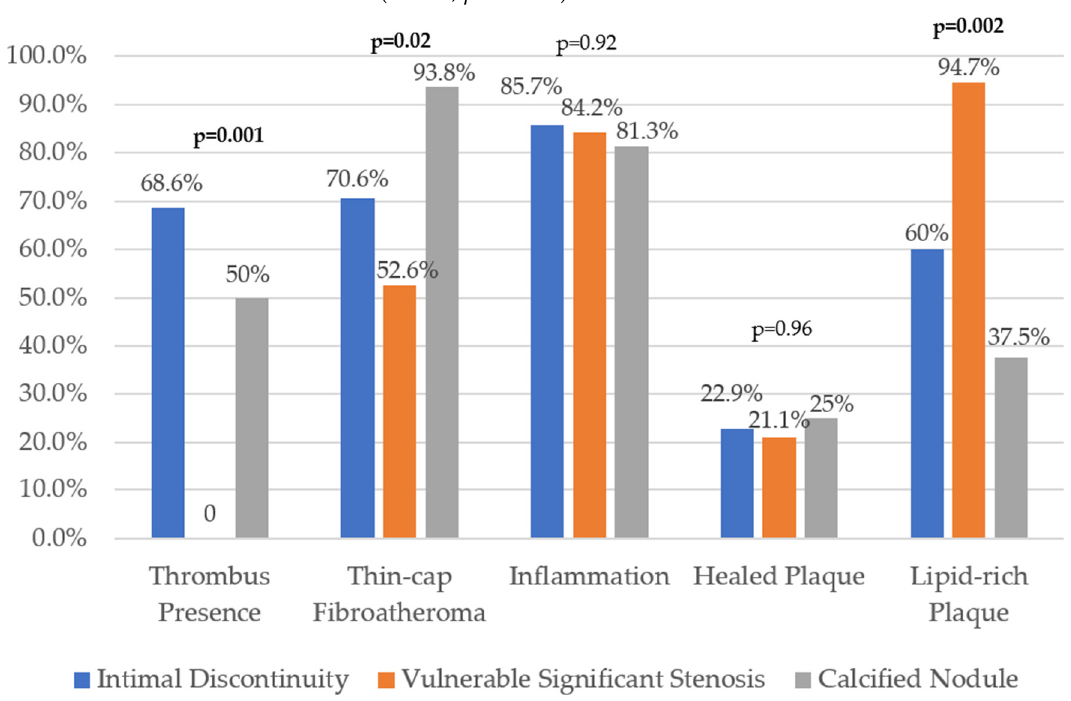
Figure 3. Main correlations for each patient group.